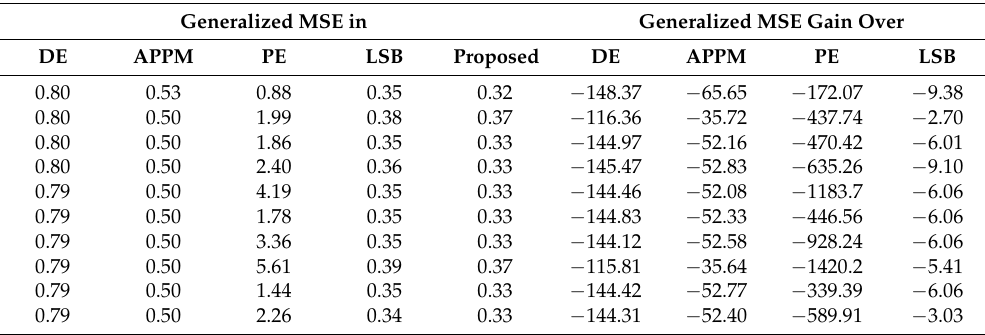
Table 2. Gain of generalized mean square error (GenMSE) over the others.